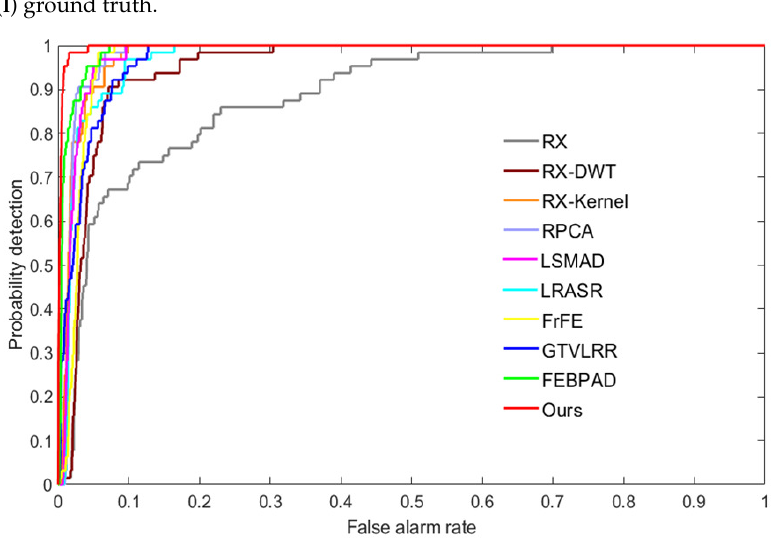
Figure 5. Detection results on the AVIRIS-I dataset: ( a ) Pseudo-color image; ( b ) RX; ( c ) RX-DWT; ( d ) RX-Kernel; ( e ) RPCA; ( f ) LSMAD; ( g ) LRASR; ( h ) FrFE; ( i ) GTVLRR; ( j ) FEBPAD; ( k ) ours; ( l ) ground truth.